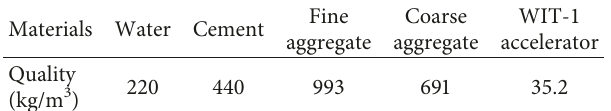
Table 7: Shotcrete mix ratio.